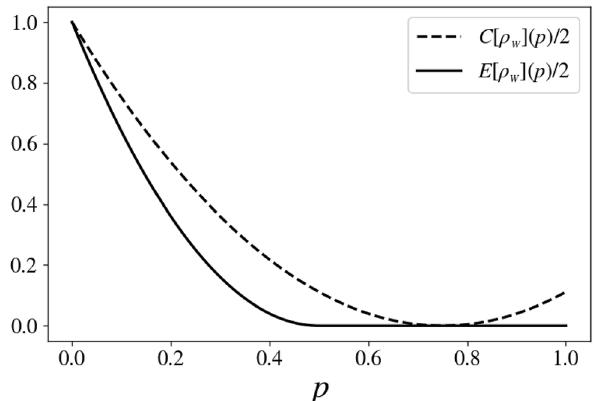
0 ) is, as expected, =